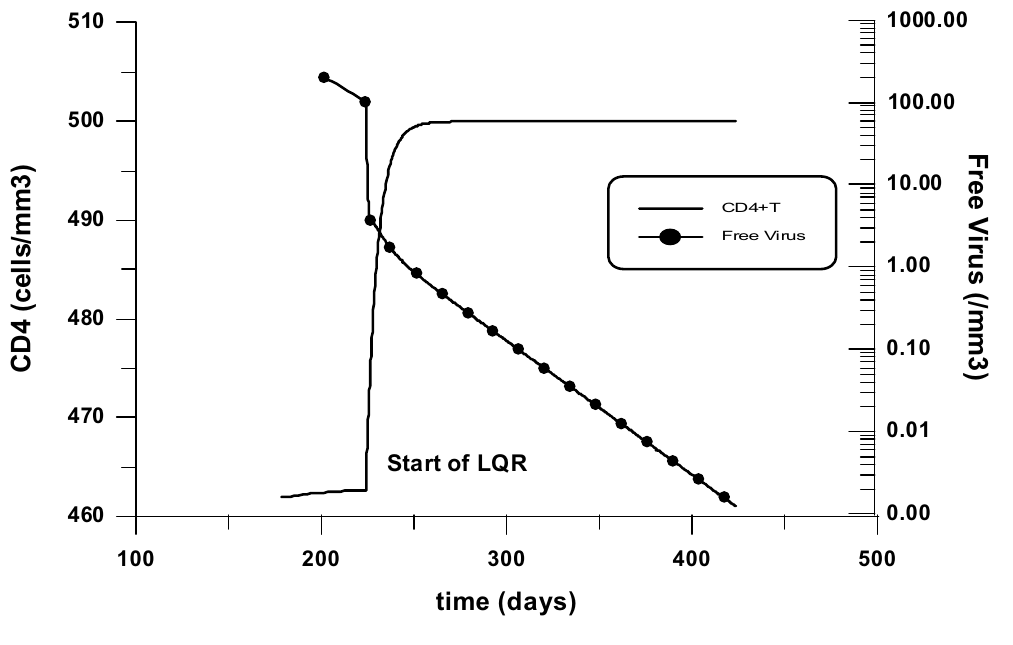
Fig. 3 – CD4 + T cells and Free Virus under LQR drug